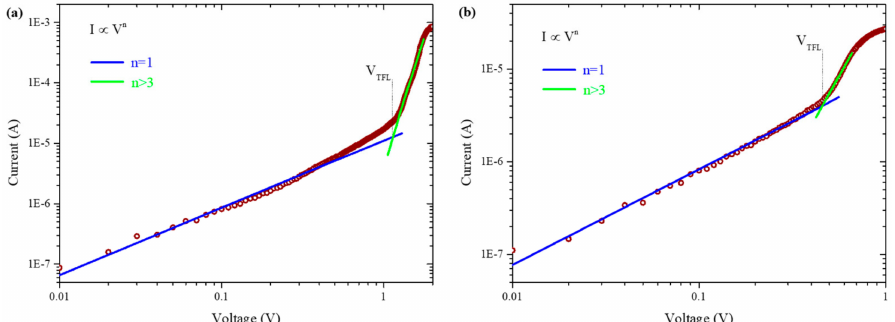
Figure 3. Characteristic current-voltage (I-V) trace (red markers) showing two di ff erent regimes for ( a ) ITO / CH 3 NH 3 PbI 3 / Au, and ( b ) ITO / TPASBP / CH 3 NH 3 PbI 3 / Au. A linear ohmic regime (I ∞ V, blue line)